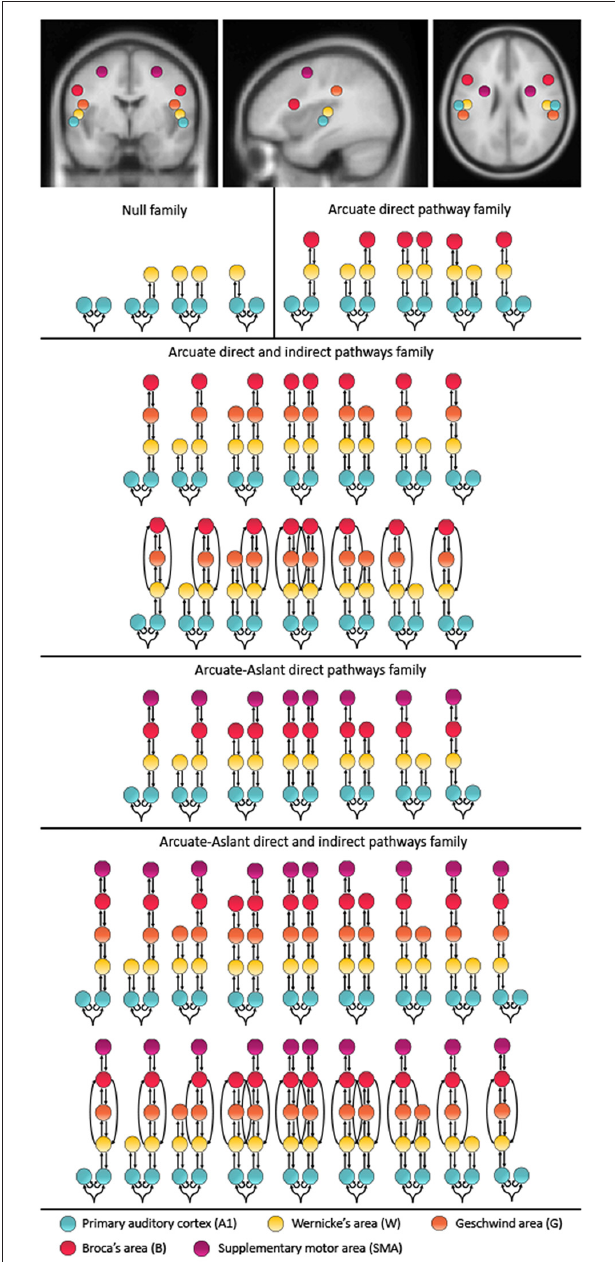
FIGURE 1 | Mean locations for the dynamic causal modeling (DCM) nodes and model space. The montreal neurological institute (MNI) coordinates include: left A1 ( − 52, − 19, 7), right A1 (50, − 21, 7), left W ( − 57, − 20, 1), right W (54, − 19, 1), left G ( − 53, − 32, 33), right G (51, − 33, 34), left B ( − 48, 13, 17), right B (49, 12, 17), left supplementary motor area (SMA; − 28, − 2, 52), SMA (28, − 1, 51). The 48 represented models were included twice, once with forward connections only and once with forward and backward connections. These 96 models were chosen to test different hypotheses about the functional anatomy of predictability to temporally cued speech. The models were combined into five families including a Null family , the Arcuate direct pathway family , the Arcuate direct and indirect pathways family , the Arcuate-Aslant direct pathways family and the Arcuate-Aslant direct and indirect pathways family